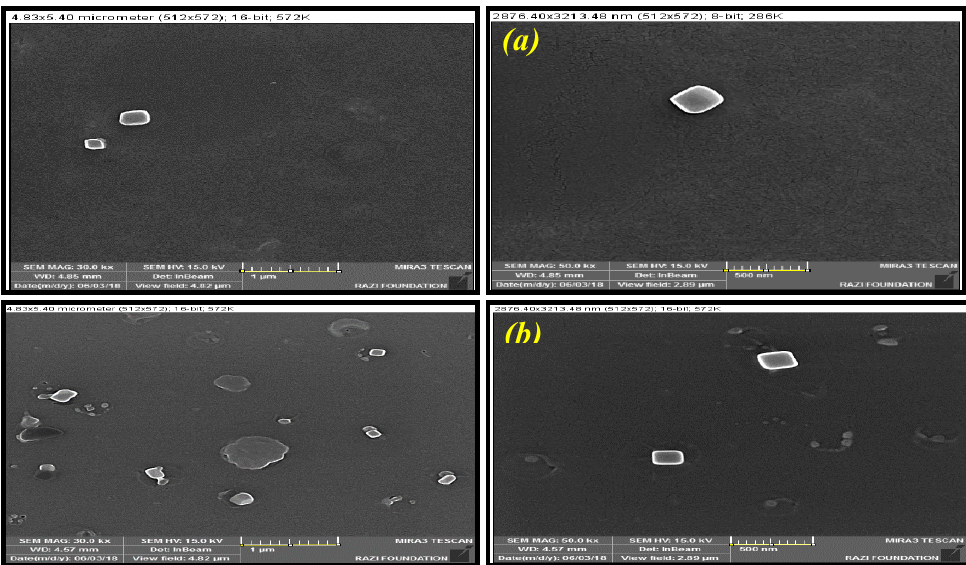
Fig. 5: FESEM pictures of (a) P3HT, (b)P3HT:PC